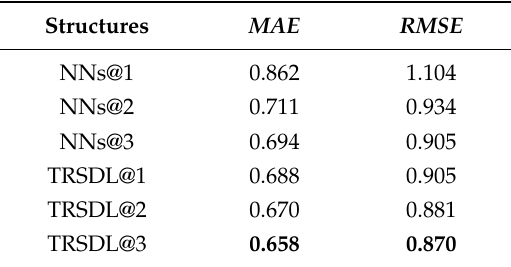
Table 4. Results of various model